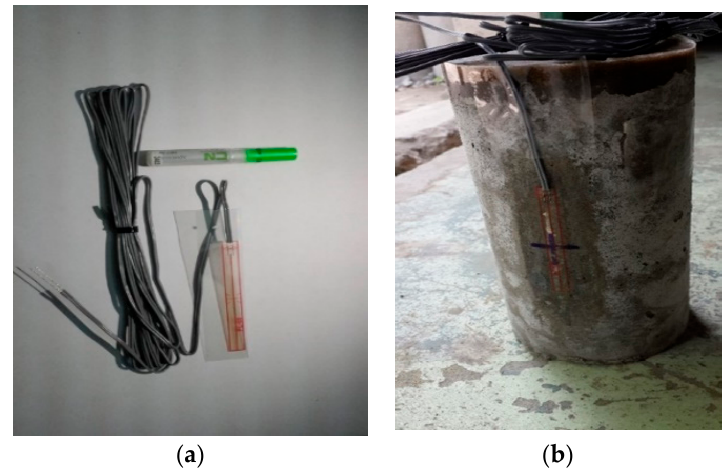
Figure 4. Specimens for the compressive test. ( a ) Strain gauge and bond; ( b ) specimen with strain gauges.